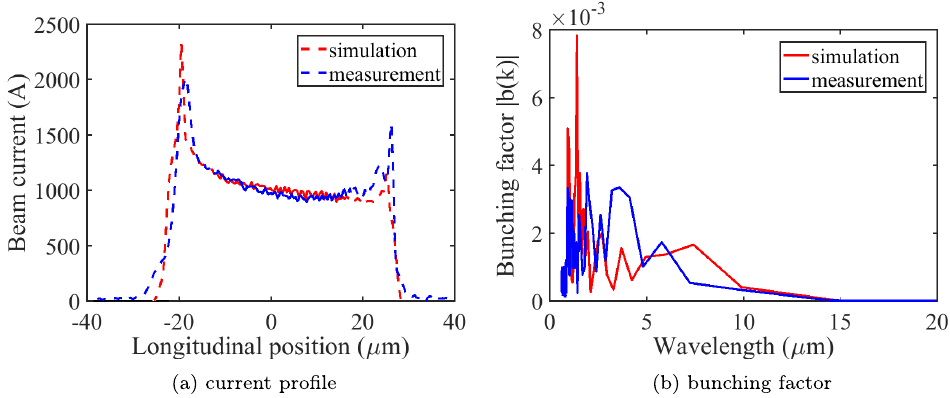
FIG. 8. The final current profile (left) and bunching factor (right) of the Fig. 7 longitudinal phase-space distribution with the laser heater at 19